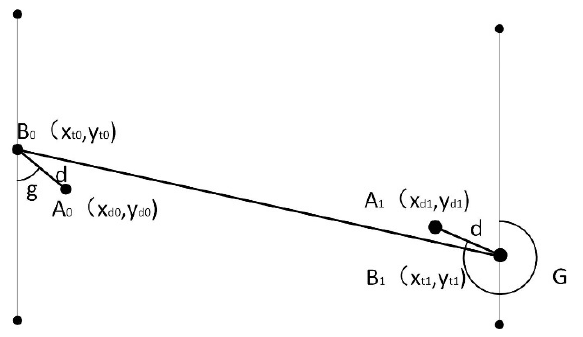
Figure 6. Future location prediction model.